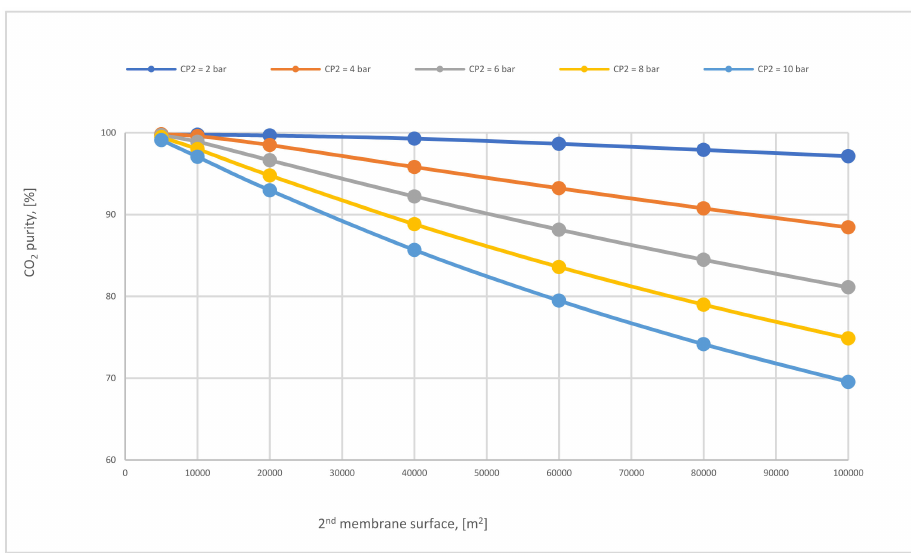
Figure 17. CO 2 purity at different 2nd compressor pressures for 2-stages of the membrane regarding 2nd membrane surface at SA 1 of 600,000 m 2 and CP 1 of 6 bar.